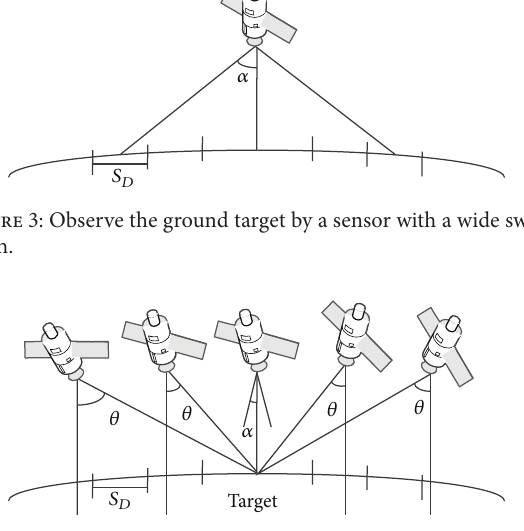
Figure 4: Observe the ground target from adjacent orbit using tilt